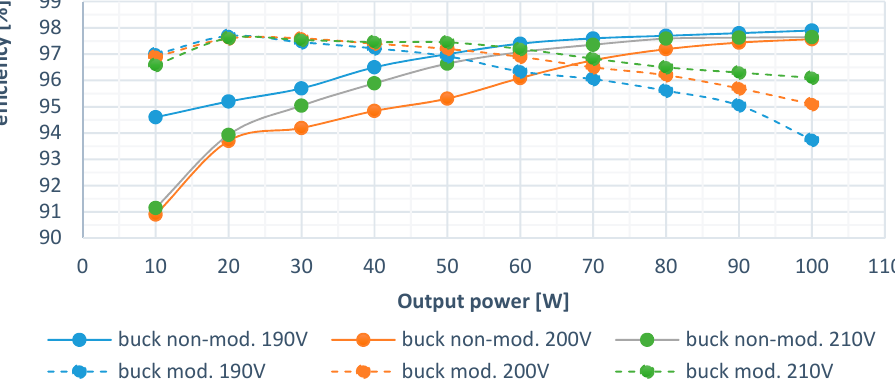
Figure 15. The dependency of efficiency on output power and input voltage for proposed bi-BB converters for buck mode.